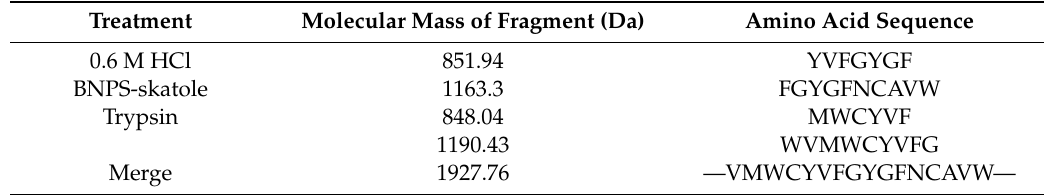
Table 3. Amino acid sequences of pantocin wh-1 fragments obtained after di ff erent fragmentation